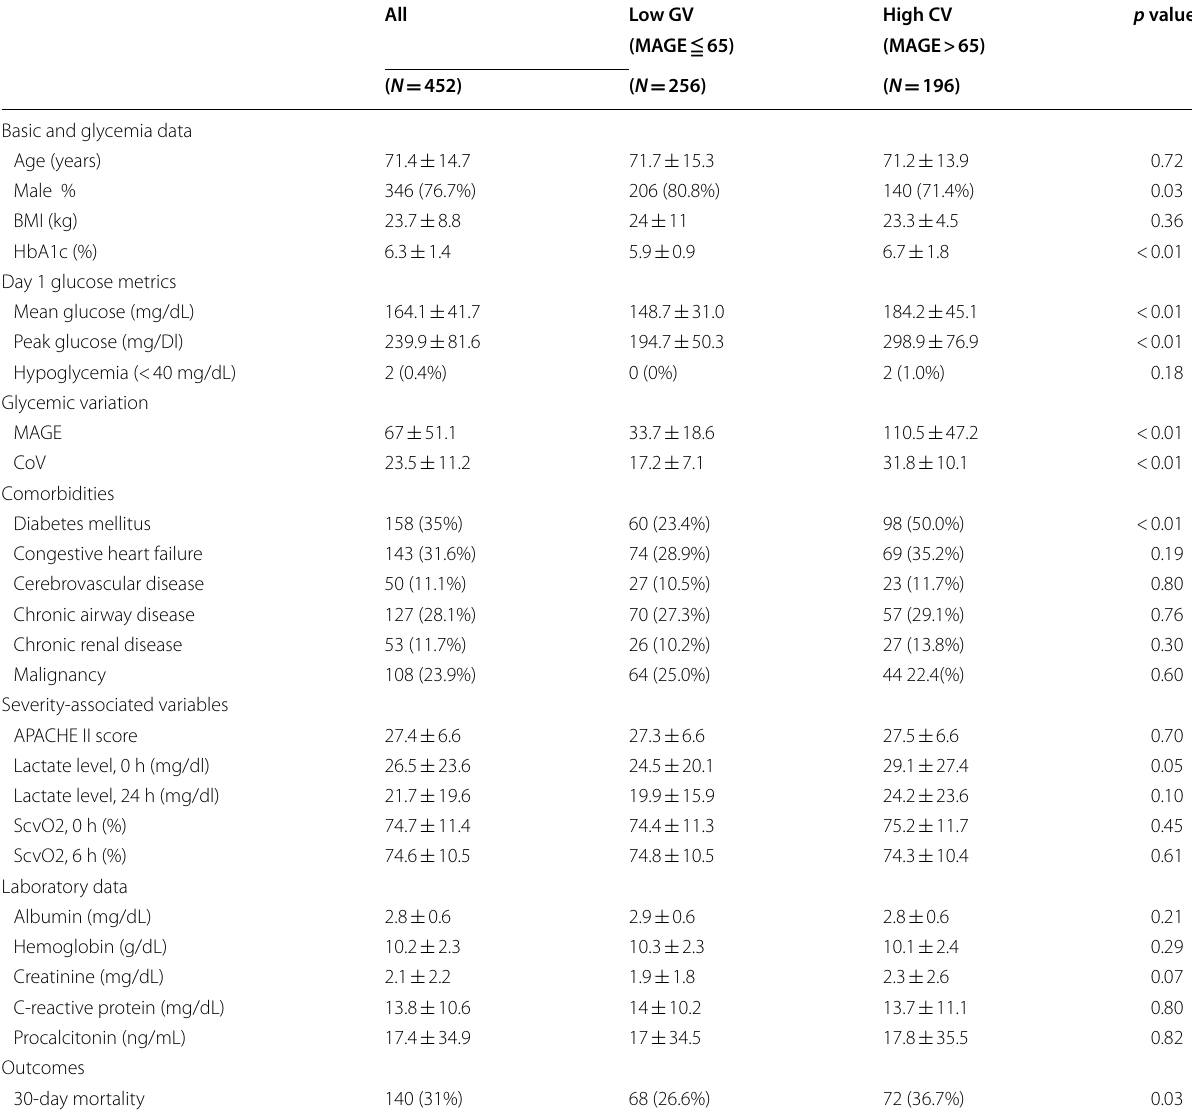
Data are presented as mean SD and N (%) ± GV glycemic variability, MAGE mean amplitude of glycemic excursions, CoV coefficient of variation, DM diabetes mellitus, BMI body-mass index, HbA1c hemoglobin A1c, APACHE II acute physiology and chronic health evaluation II, ScvO2 central venous oxygen